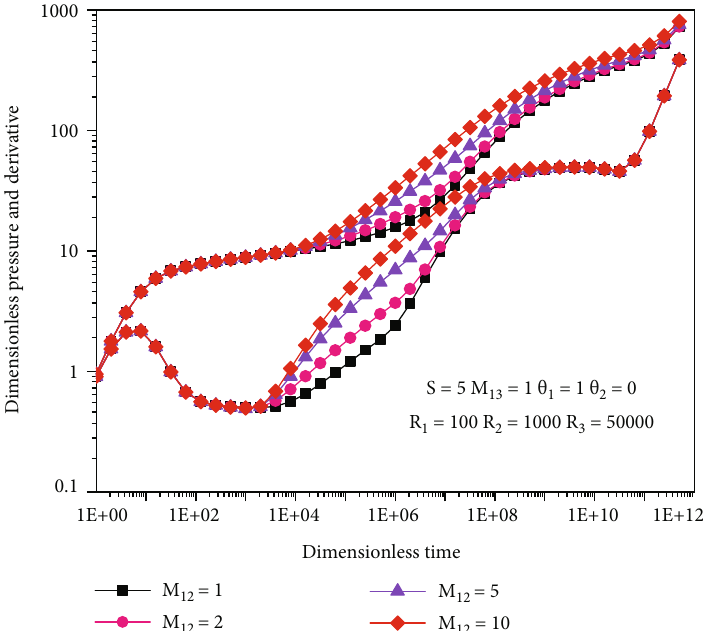
Figure 11: In fl uence of the mobility ratio between the homogeneous radial compound inner zone and transition zone in three zones on the well bottom pressure